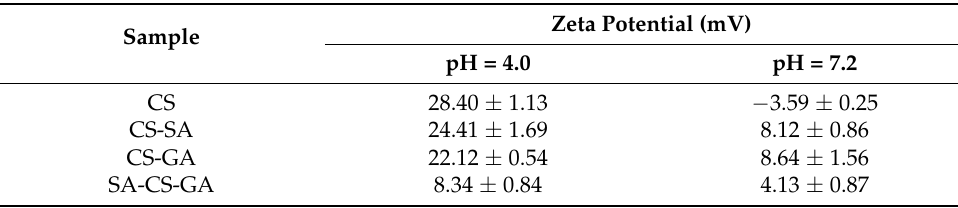
Table 3. Zeta potential of novel chitosan derivatives at pH = 4.0 and pH = 7.2 in PBS. Data are presented as mean ± SD of 3 independent experiments.